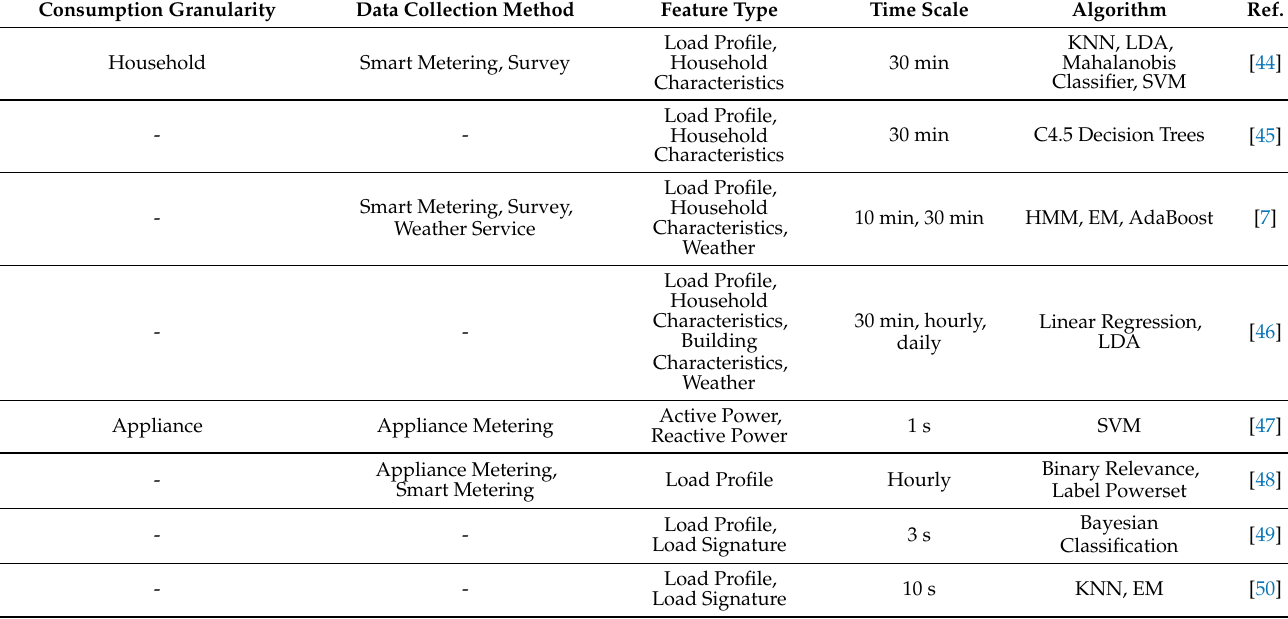
Table 1. Data Collection